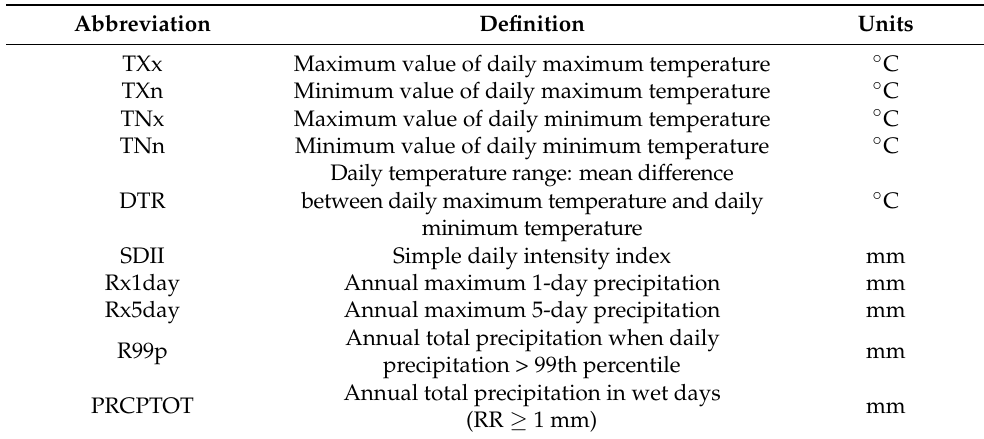
Table 1. Extreme temperature and temperature indices and their